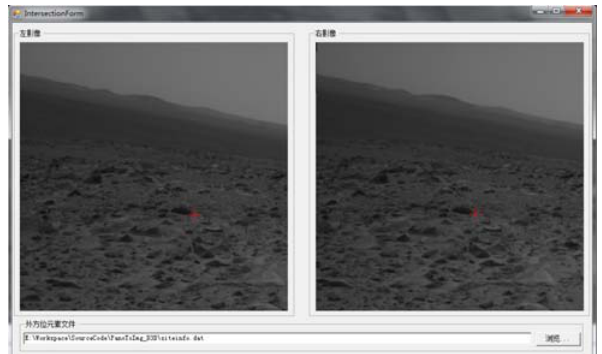
Figure 8. Stereo measurement window associated with the panorama viewer